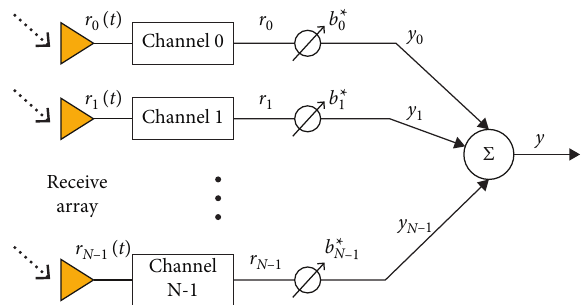
Figure 2: Digital beamforming at the receiving end for the standard FDA and FDA-MIMO